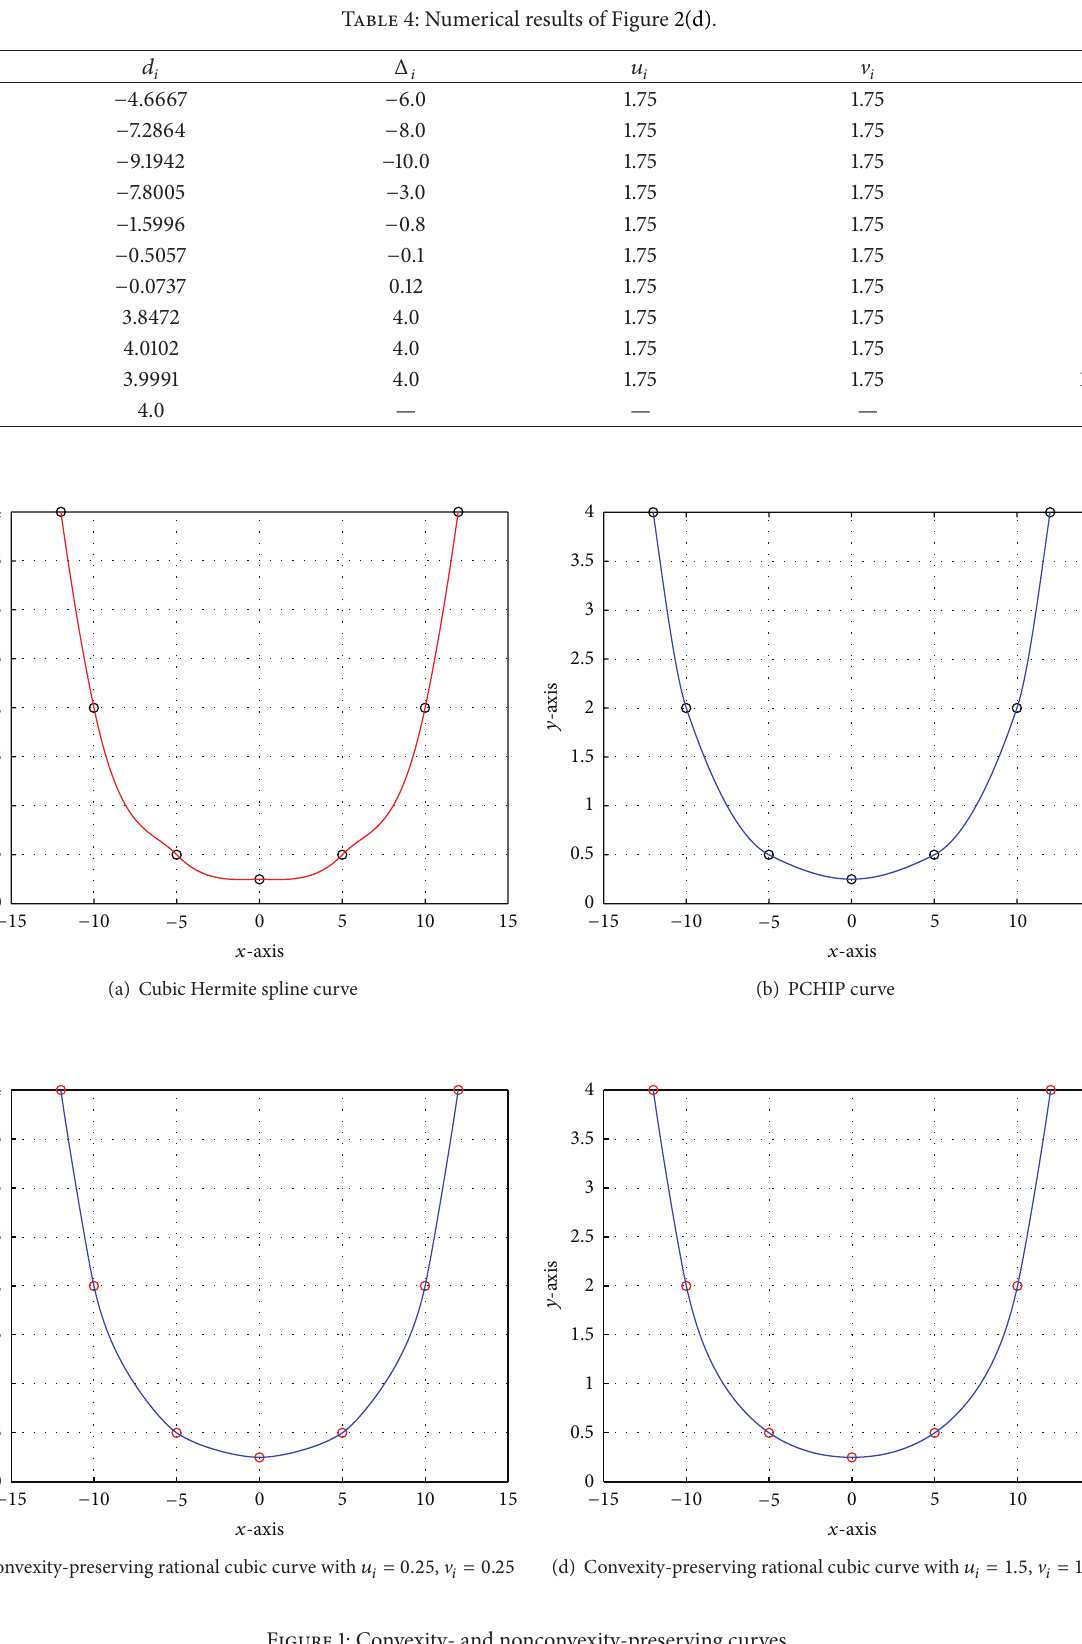
Figure 1: Convexity- and nonconvexity-preserving